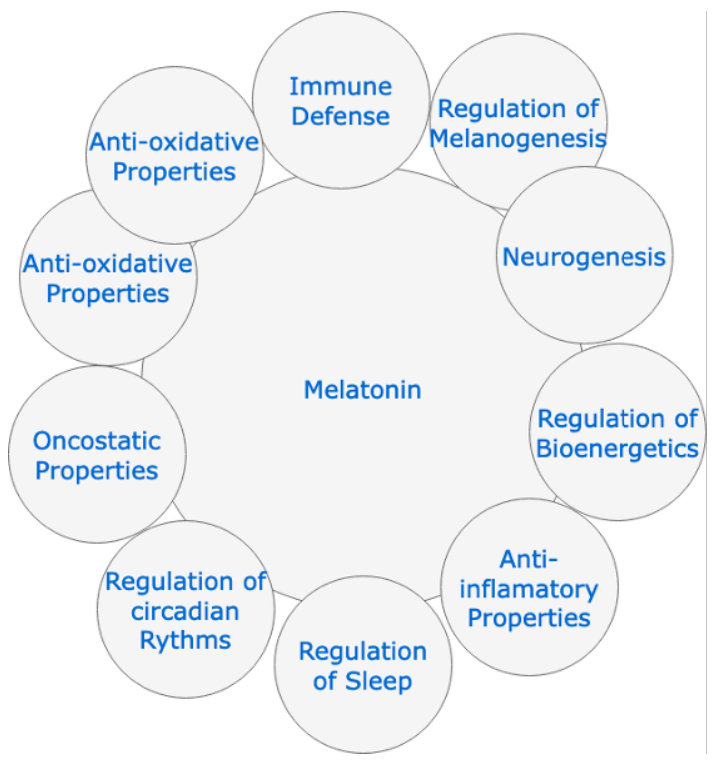
Figure 2. Physiological effects of melatonin.